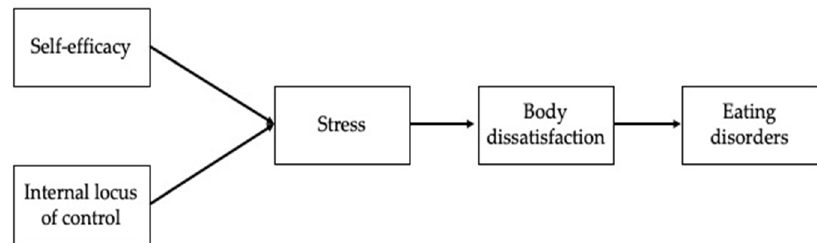
Figure 1. The Hypothesized